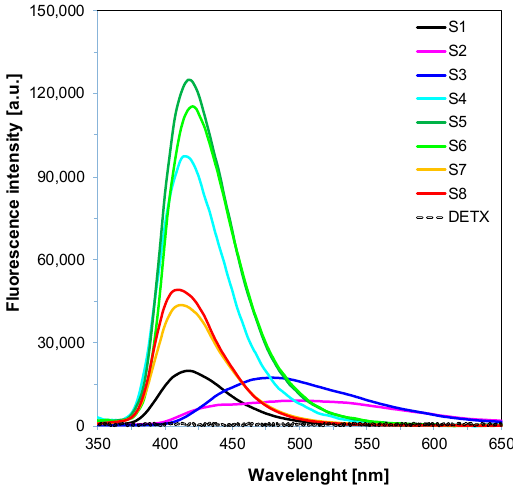
Figure 2. Fluorescence spectra of the 2-amino-4,6-diphenyl-pyridine-3-carbonitrile derivatives in acetonitrile in extinction at 320 nm with integration time of 1 s.